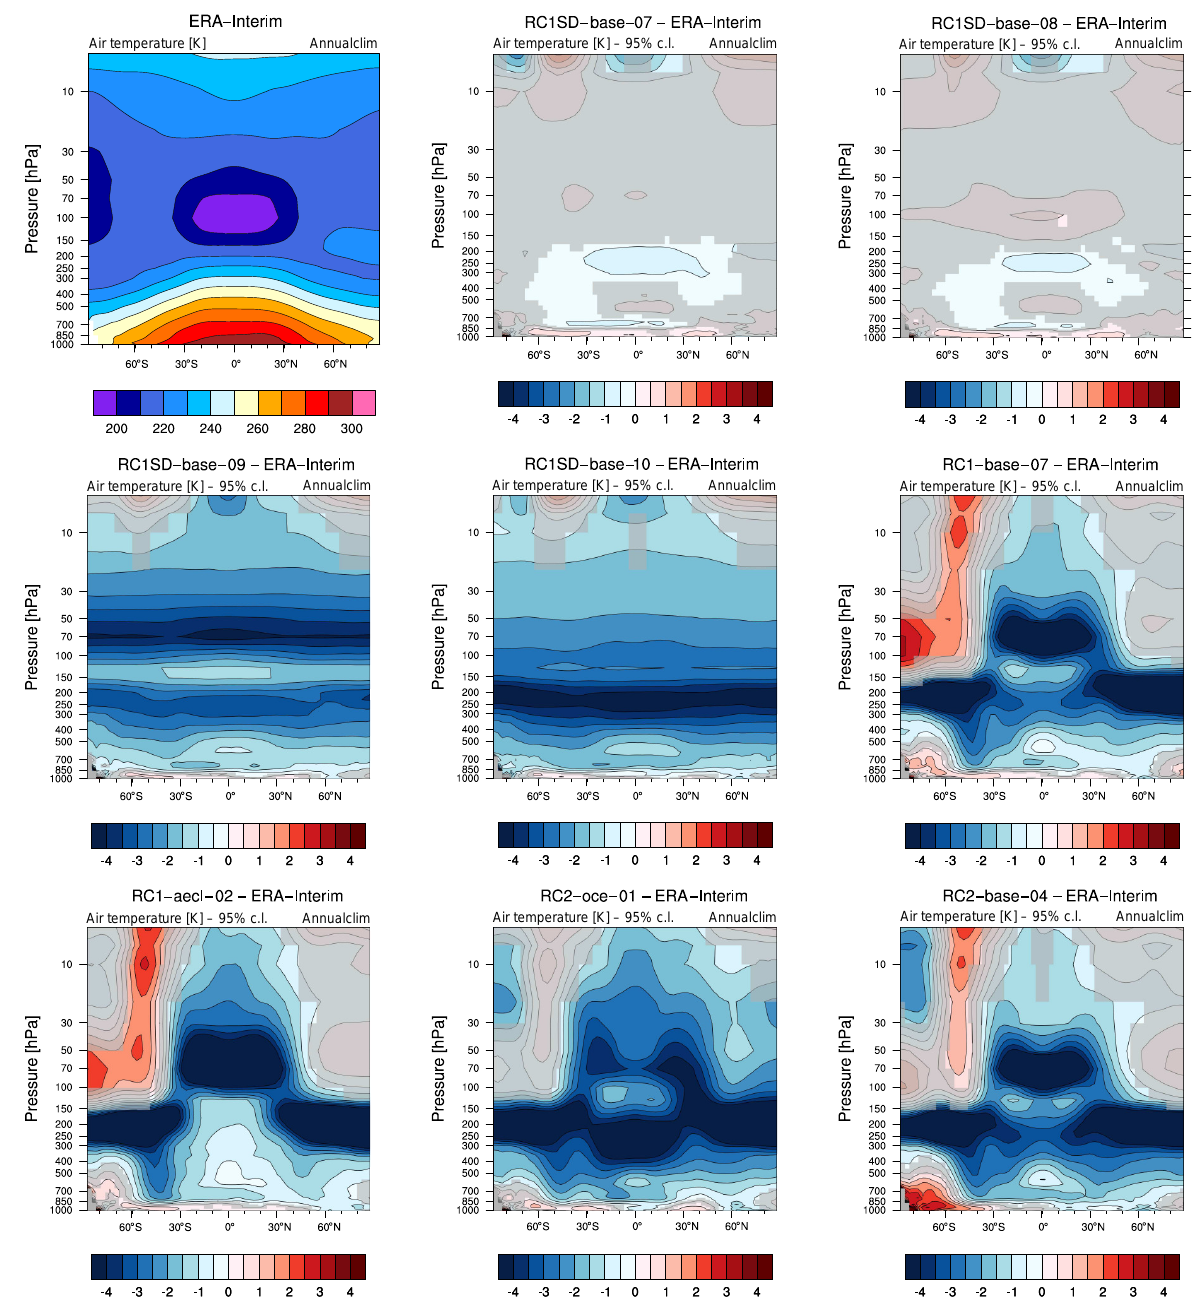
Figure 12. Upper left panel: climatology of annual average total dry air temperature of ERA-Interim in K. The data were monthly and zonally averaged for the period 2000–2010. Other panels: dry air temperature differences (in K) of the simulations compared to ERA-Interim data. The differences, unless grey shaded, are significant on a 95% confidence level according to a two-sided Welch’s